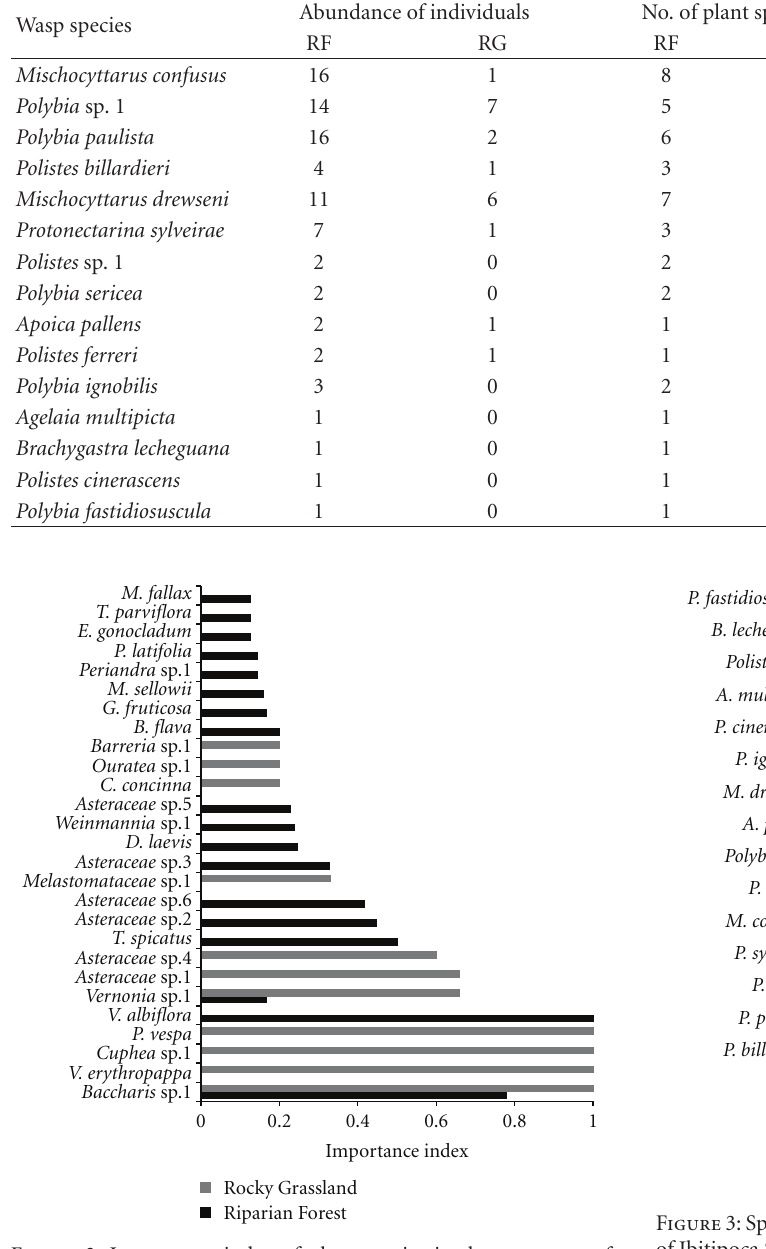
Figure 2: Importance index of plant species in the two areas of Ibitipoca State Park (Riparian Forest and Rocky Grassland), MG, Brazil, during the period from November 2007 to October 2008.